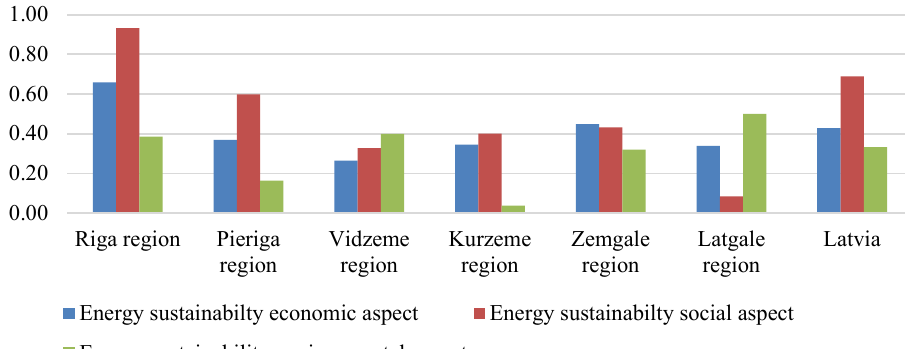
Fig. 2. Energy sustainability indicator and its components in Latvia's statistical planning regions.